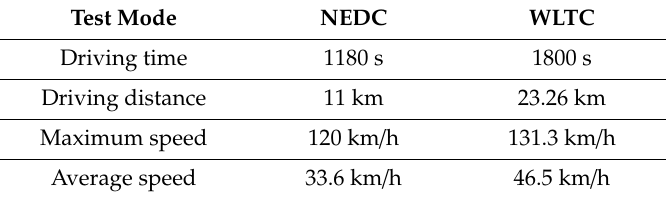
Figure 4. WLTC class vehicle speed profile [4]. Table 7. Comparison of NEDC and WLTC test modes.